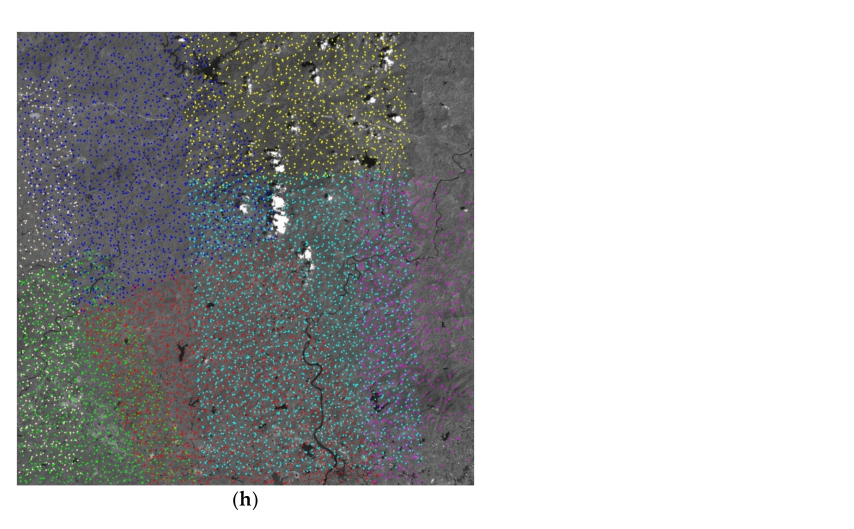
Figure 16. The obtained matches from all reference SAR images for the optical satellite image GF-1-3. ( a – g ) display the locations of matches on all SAR reference images. ( h ) displays the locations of all obtained matches on GF-1-3, where the color of a point indicates the SAR image to which it is matched.